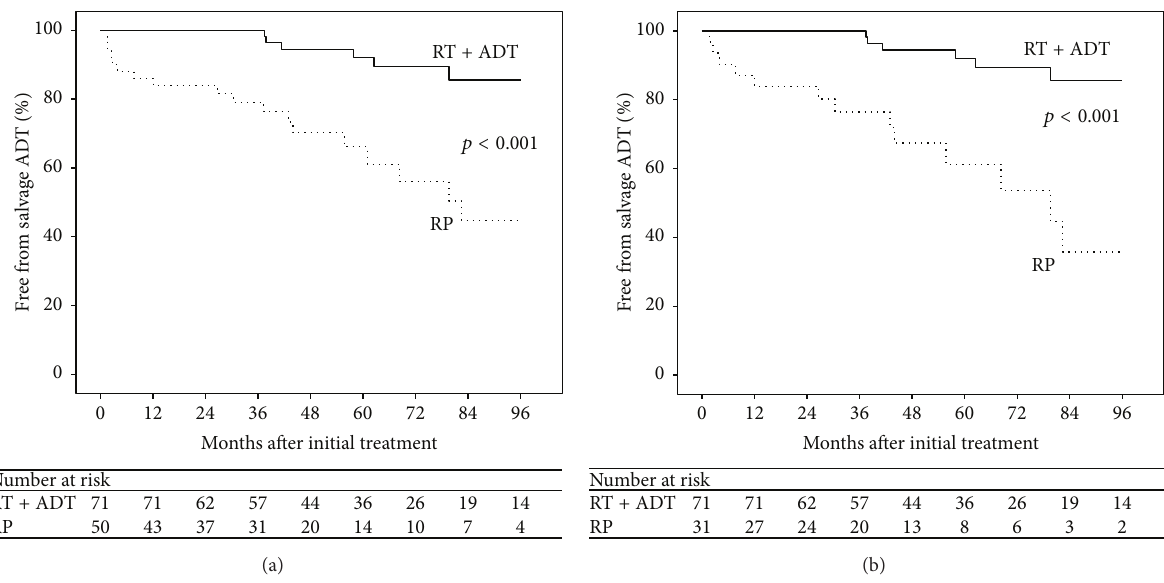
Figure 4: Kaplan-Meier estimate of freedom from salvage androgen deprivation therapy (ADT) in RT + ADT and RP patients with GS ≥ 8 on biopsy or pathology (a) and patients with GS ≥ 8 on biopsy